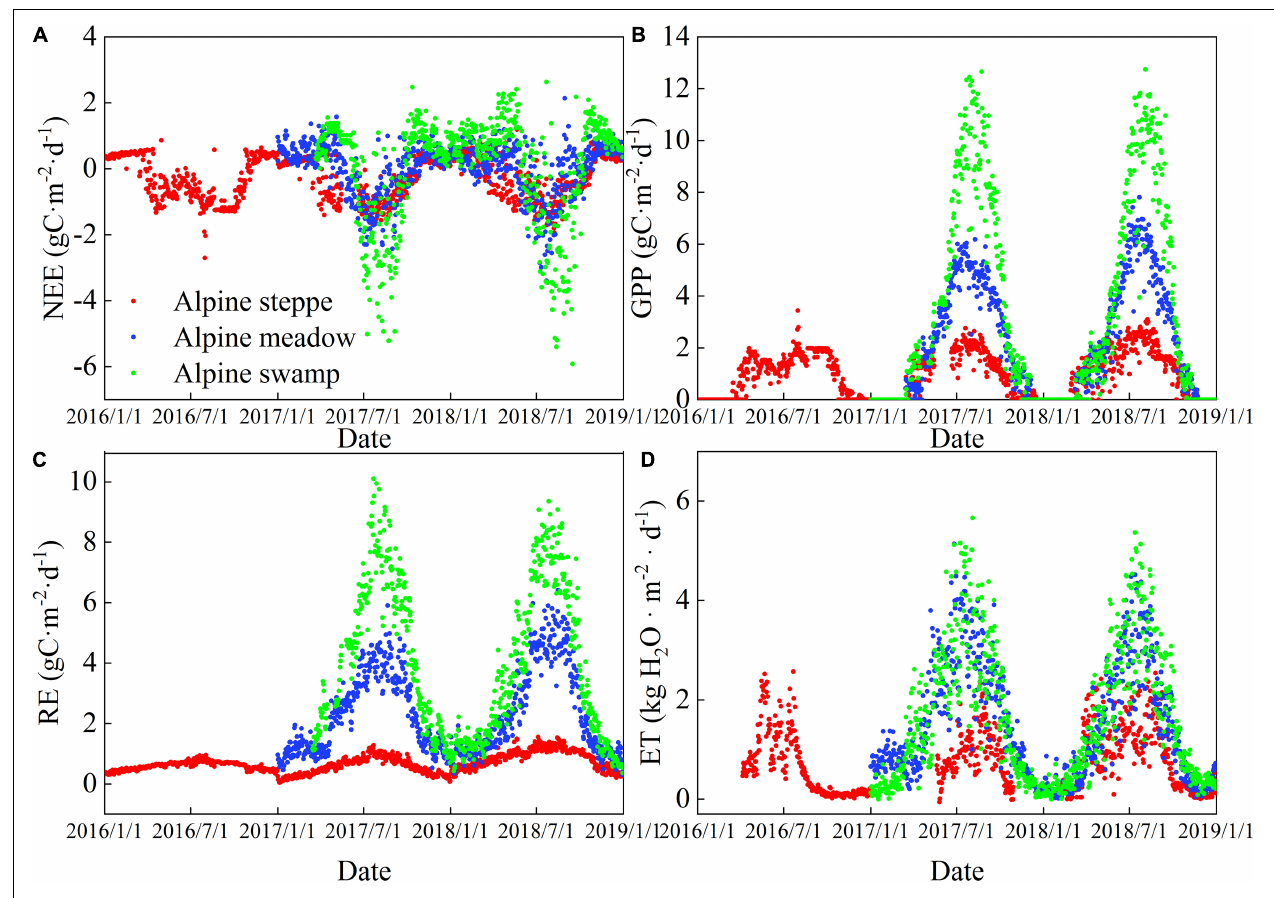
FIGURE 3 | Daily time series of (A) net ecosystem exchange, (B) gross primary productivity, (C) respiration, and (D) evapotranspiration (ET) at the alpine steppe, alpine meadow, and alpine swamp